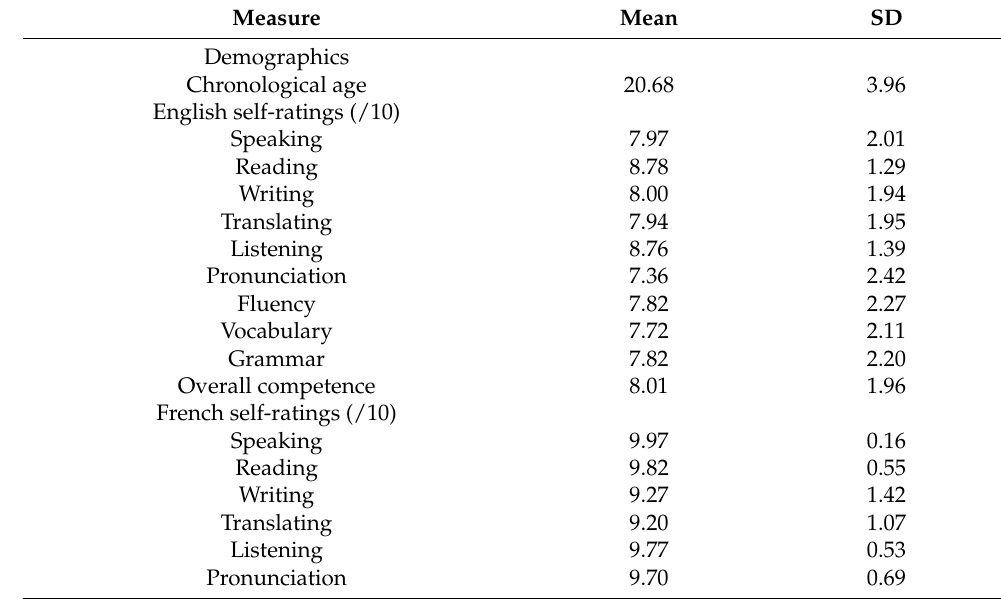
Table A1. Full participant characteristics (Experiment 1). Self-ratings were collected on a 1–10 scale